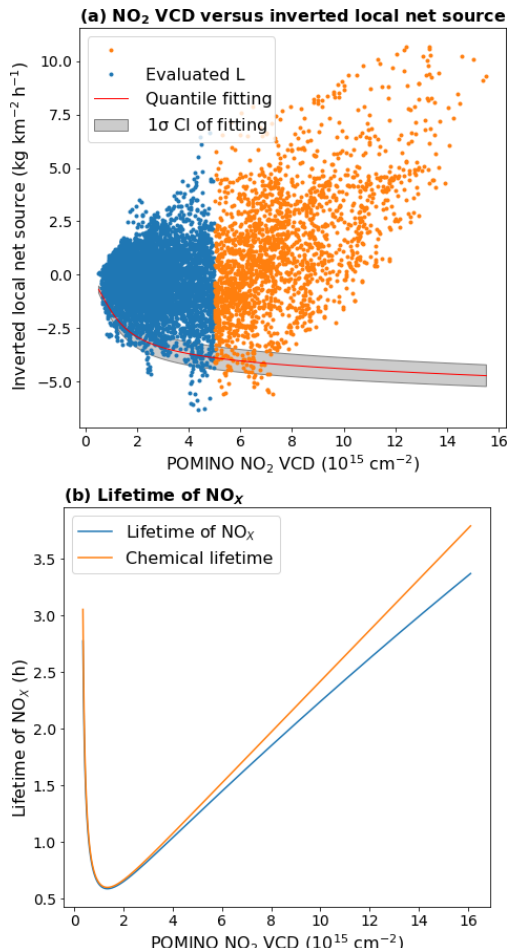
Figure C1. (a) Scatter plot for POMINO NO 2 VCDs ( x axis) and derived local net sources ( y axis) across individual grid cells. Grid cells with NO 2 VCDs below (above) 5 × 10 15 molec.cm − 2 are col- ored in blue (orange). The red line and shading denote the median and uncertainty (1 σ CI) of the quantile fitting, respectively, to esti- mate the nonlinear relationship between NO 2 VCD and NO x life- time, based on data in the low-emission areas. (b) The derived rela- tionship between NO 2 VCD and NO x lifetime across the range of NO 2 VCDs in the YRD